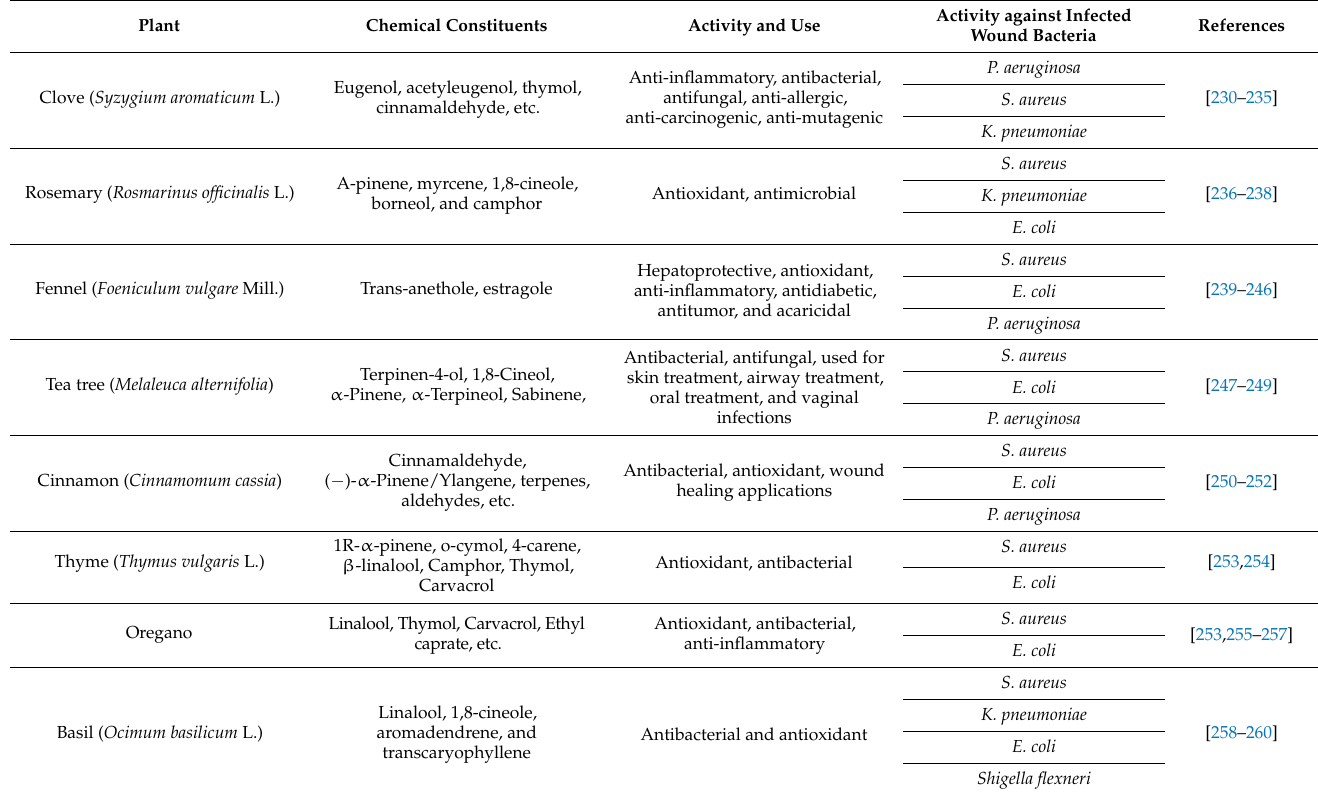
Table 3. Application and activity of antimicrobial essential